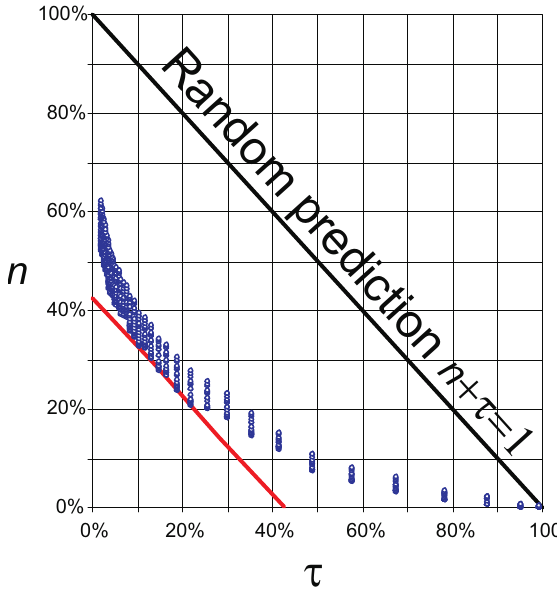
Fig. 4. The error diagram for Eskdalemuir. Daily values differ-